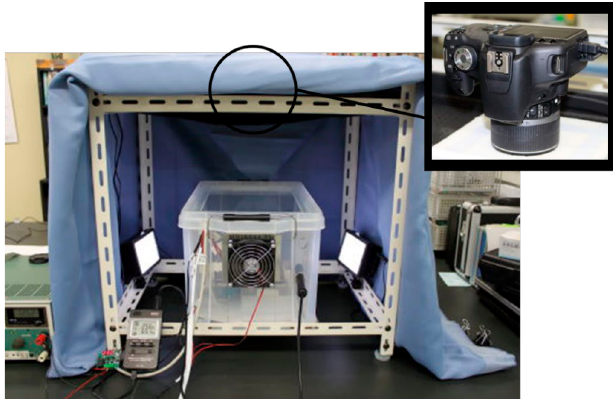
Fig. 2: Experimental equipment for continuous storage